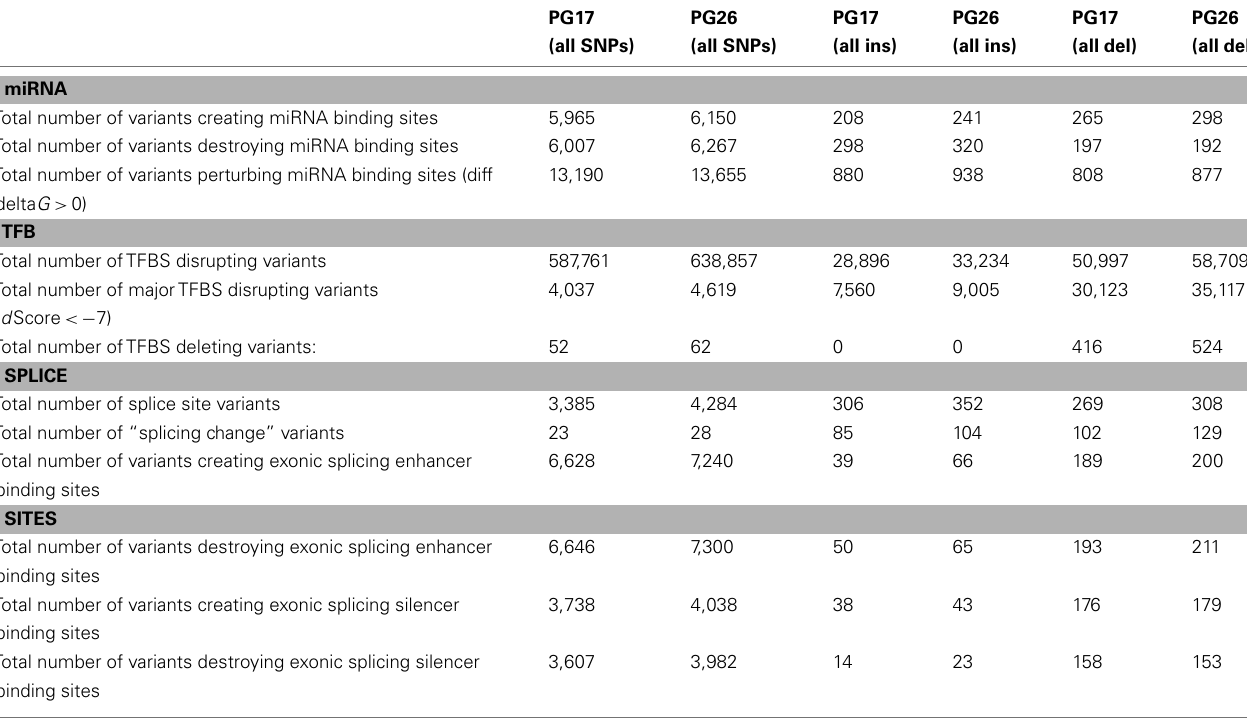
TableA5 | Predicted functions (TFBS and miRs).